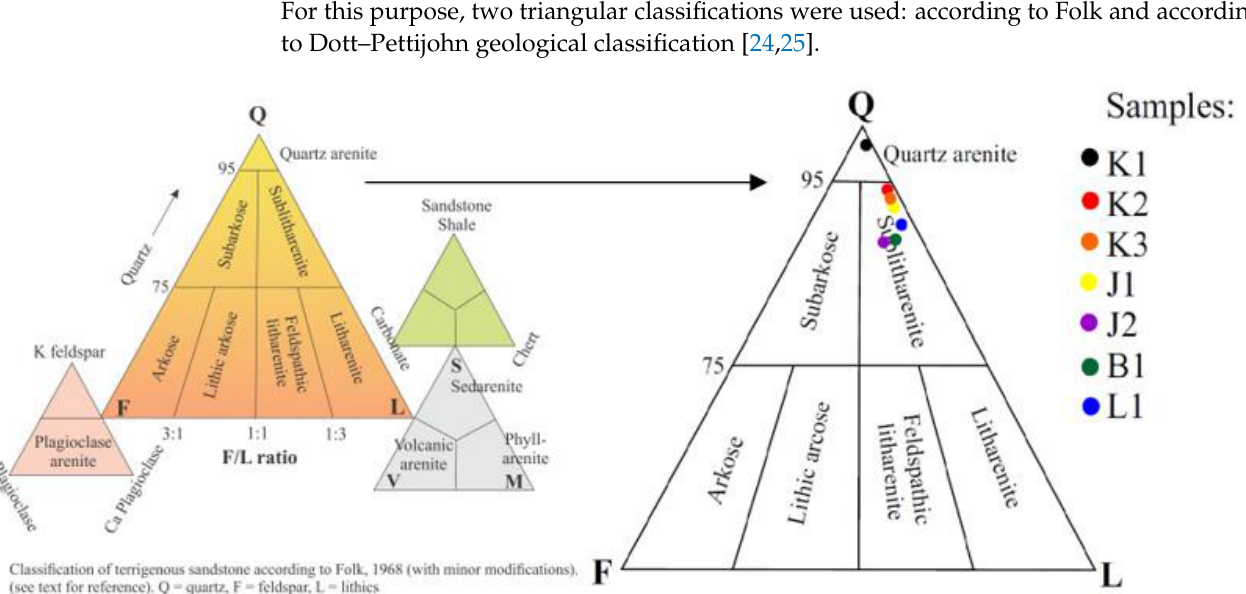
Figure 17. Classification of tested sandstones according to the Dott–Pettijohn triangle [24,25]. According to the Folk classification, the tested sandstones were classified as sublitharenite, while according to the Dott–Pettijohn classification, they were classified as subarcoses. Only the K1 sample, according to both classifications, was included in the quartz arenite group. 4.2. Characteristics of Physical and Mechanical Properties of Sandstones The results obtained from the determination of the bulk density, effective porosity, and water absorption coefficient of seven types of sandstone are presented in Table 3. The table summarizes the average values of five replicates for the determination of a given parameter.